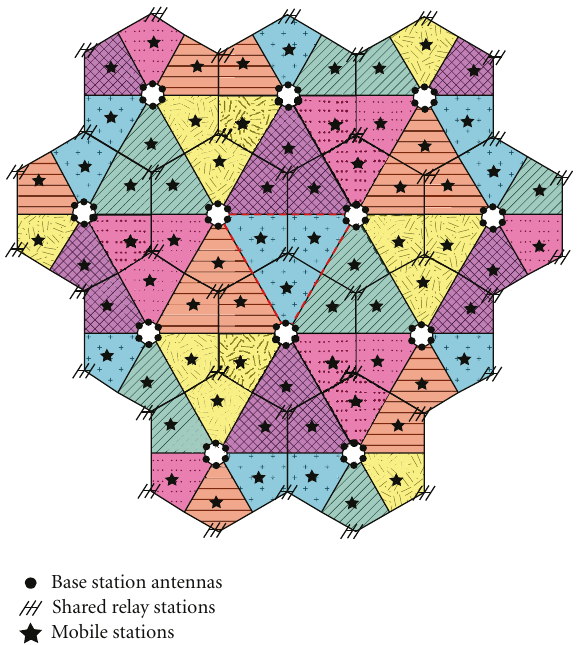
Figure 7: System model under consideration for the simulations presented in this paper. The focus is on the triangular area in the center of the network. This figure also shows the frequency reuse pattern for the shared relay and base station coordination under reuse factor 6.